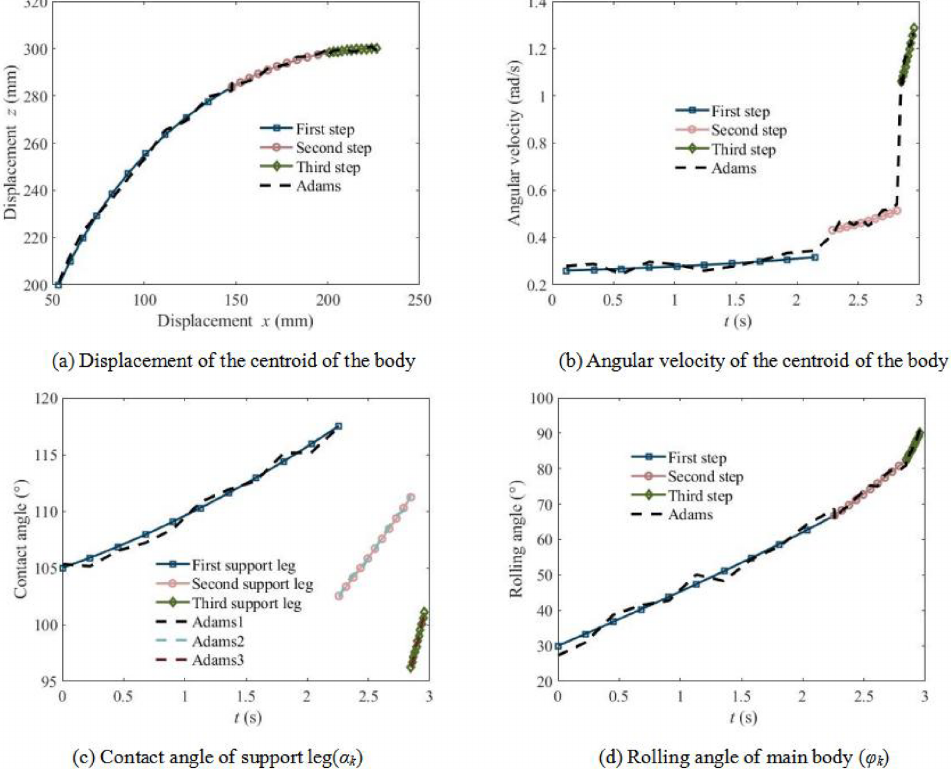
Figure 7. Kinematic parameters changing with the time.